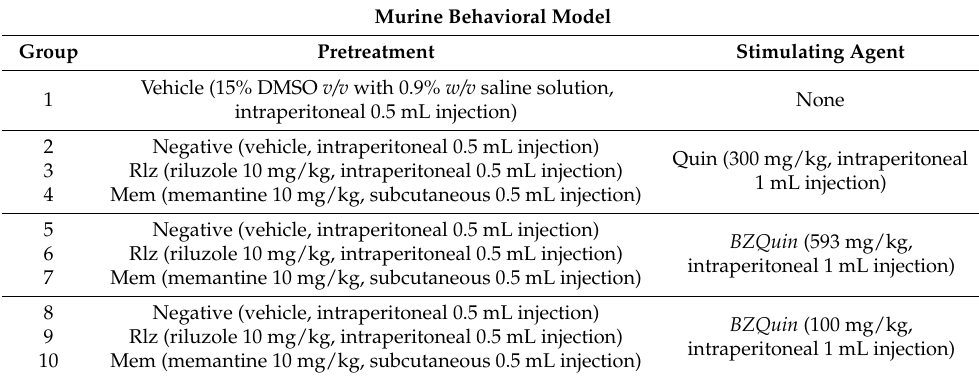
Table 3. Experimental design of the murine behavioral